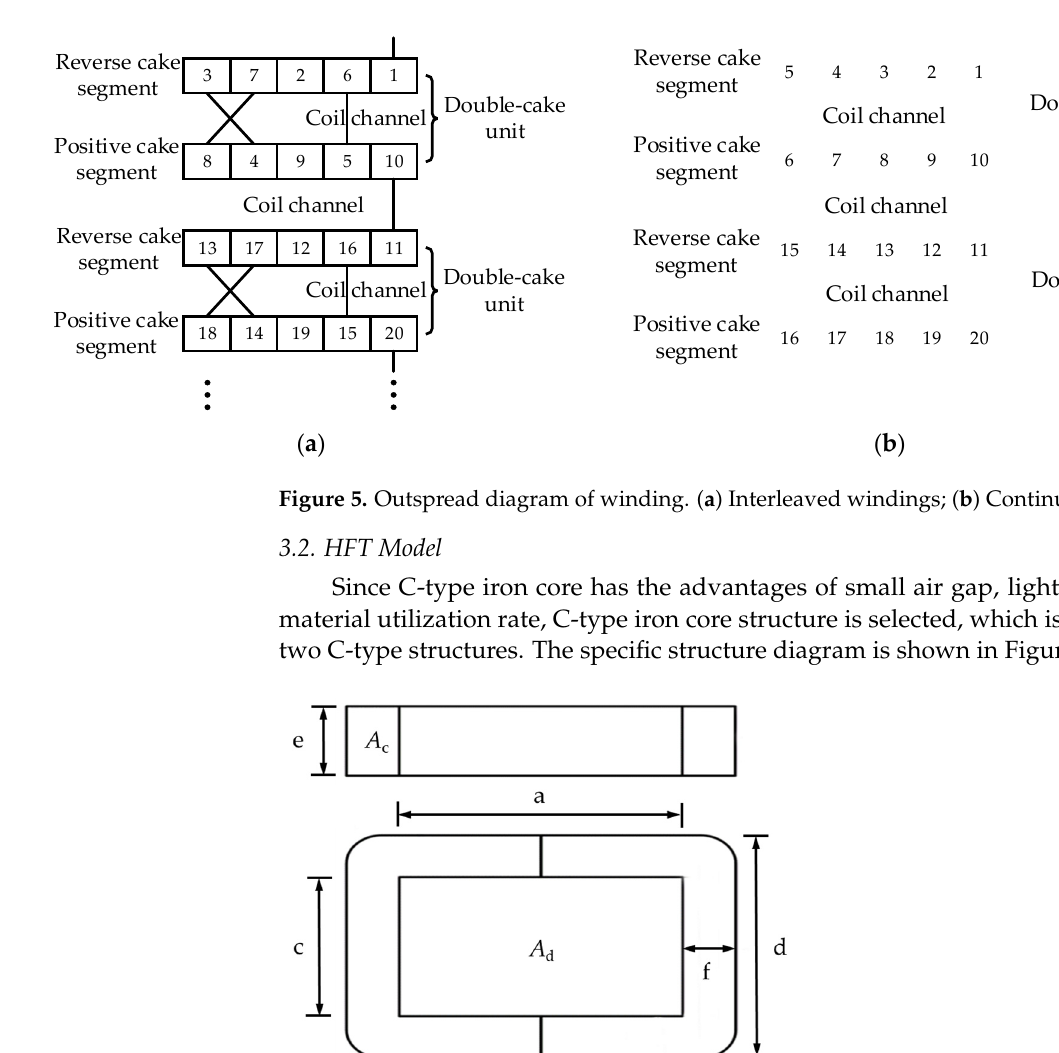
Figure 4. Grid side winding model. ( a ) Interleaved windings; ( b ) Continuous windings.